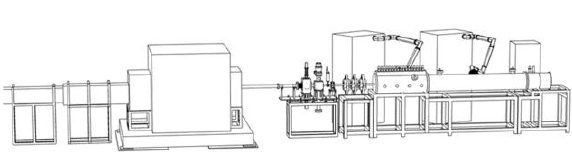
Fig.1 RIKEN Accelerator-driven compact Neutron Source, RANS. Proton linear accelerator of 7 MeV (right), target station (center) with Be target and neutron beamline